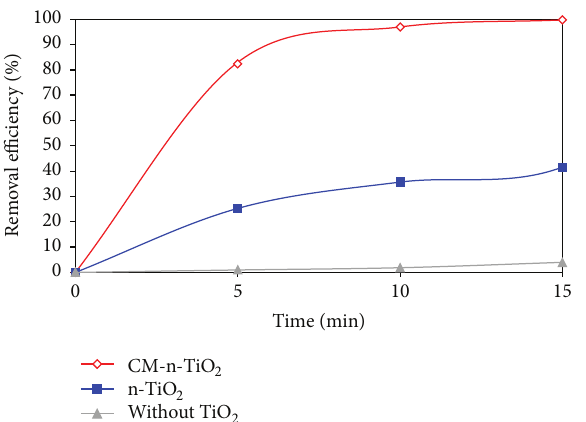
Figure 4: Photocatalytic degradation of a mixture of Ar 1254 (0.5 ppm) and Ar 1260 (0.5 ppm) in seawater using n-TiO 2 and CM- n-TiO 2 under illumination of UV light.